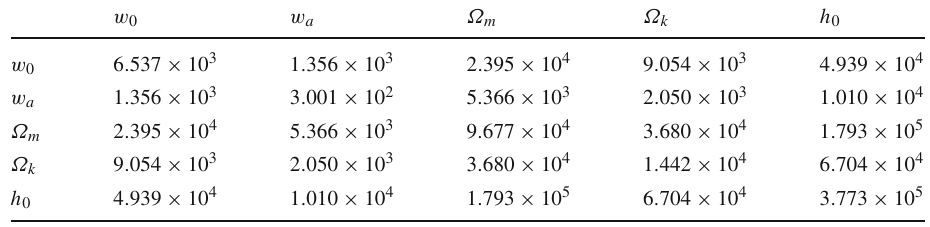
Table 10 Projected constraints on cosmological parameters from the DESI